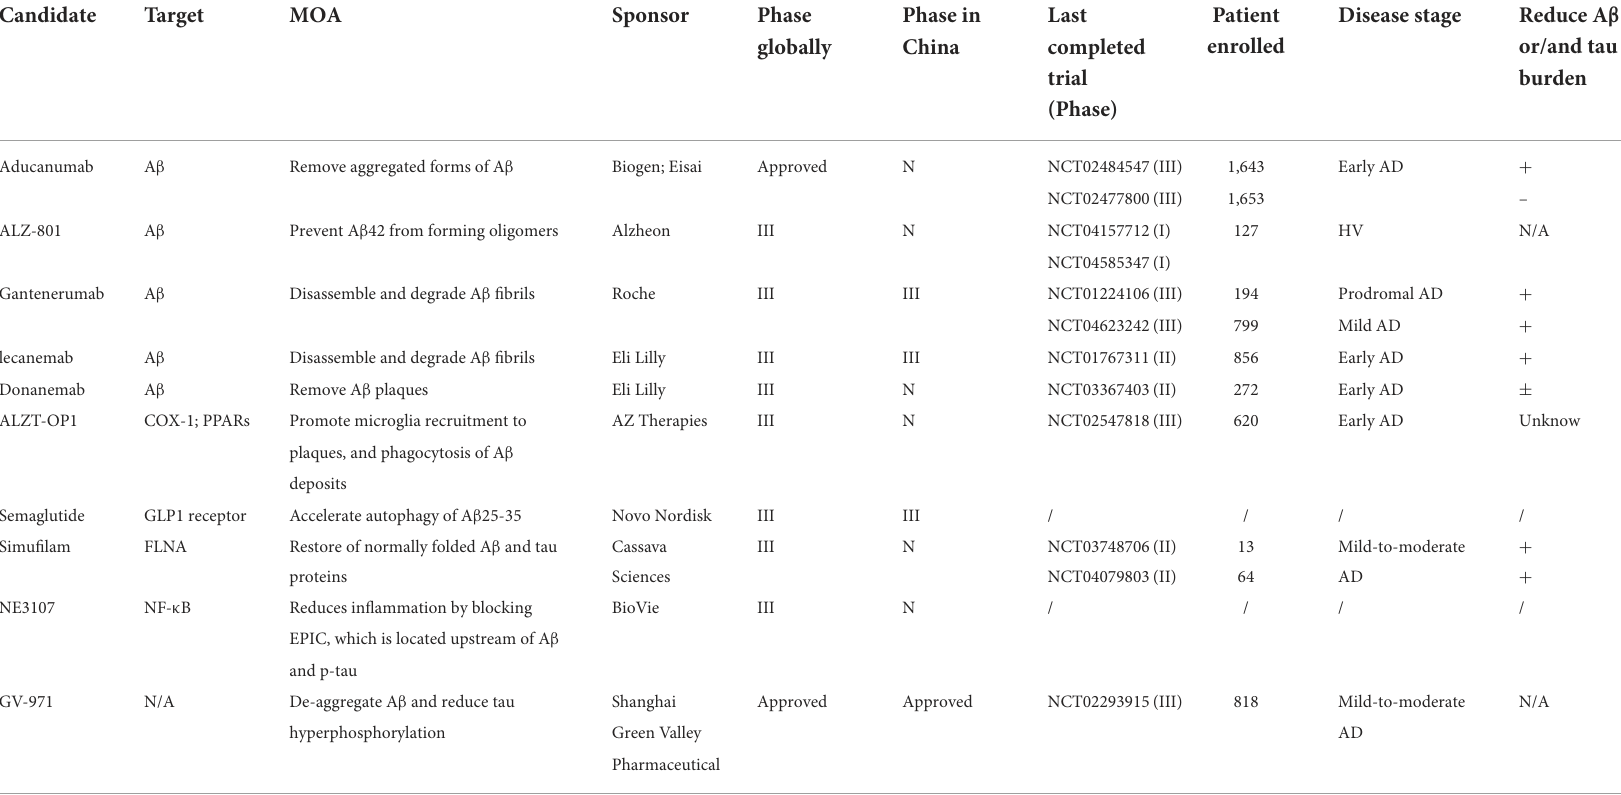
TABLE 1 Disease-modifying therapy in active development from 2017 to